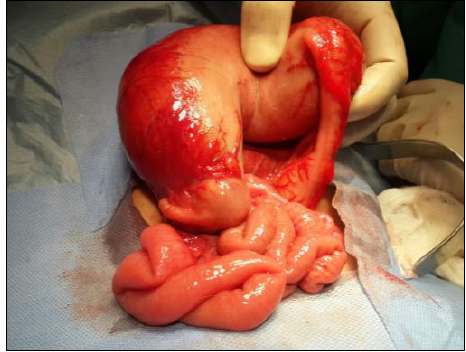
Figure 2: Segmental dilatation of the colon in the first case. All the laboratory parameters were within normal range. An intraperitoneal drain was passed; neither air nor stool was noted during drain insertion. At laparotomy, a dilated segment of colon starting from ileocecal junction to mid-transverse colon was found (Fig. 2). The involved segment (CSD) was re- sected and distal ileostomy with colonic mucous fistula was made. The postoperative recovery was uneventful and the child was discharged on 4th postoperative day. Histopathological examination of the specimen revealed colonic tissue with normal ganglion cells.